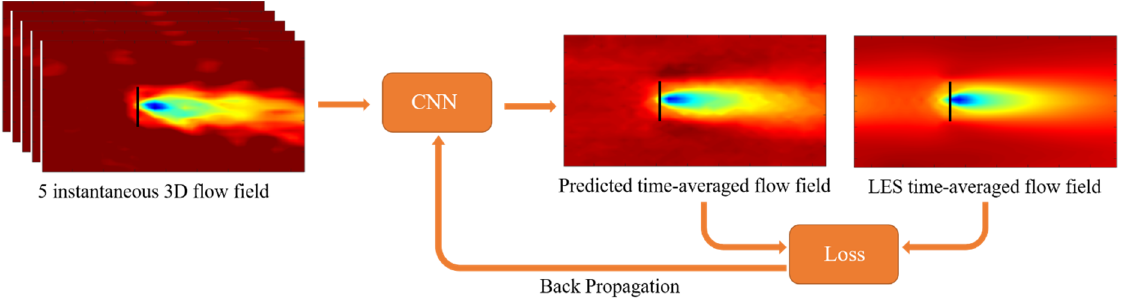
Figure 9. Schematic of the training procedure to develop the CNN. The instantaneous velocity fields are fed into the CNN as the input signal while the time-averaged windwise velocity field is enforced as the target of the output signal.